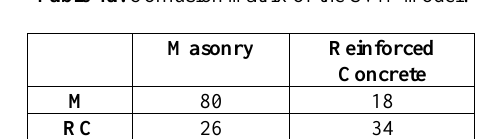
Table 4a. Confusion matrix of the SVM model.